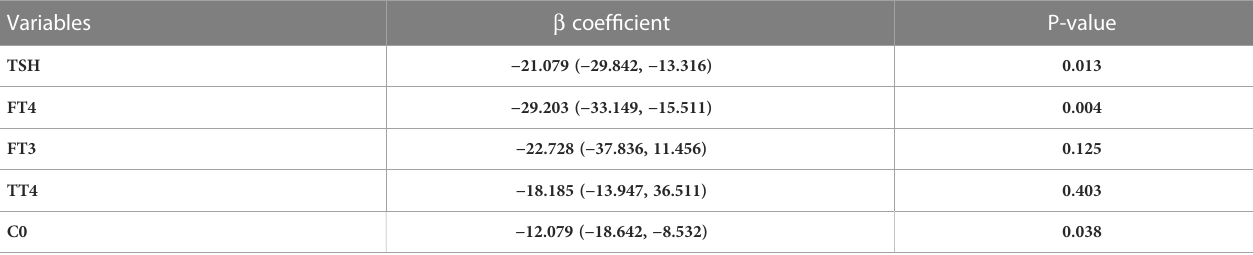
Bold values are presented as mean ± SD. TSH, thyroid-stimulating hormone; FT4, free thyroxine; FT3, free triiodothyronine; TT4, total thyroxine; C0, free carnitine.